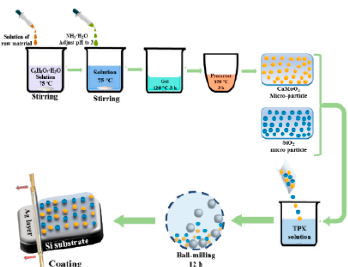
Figure 1. Schematic of the preparation process of the bilayer selective emitter.